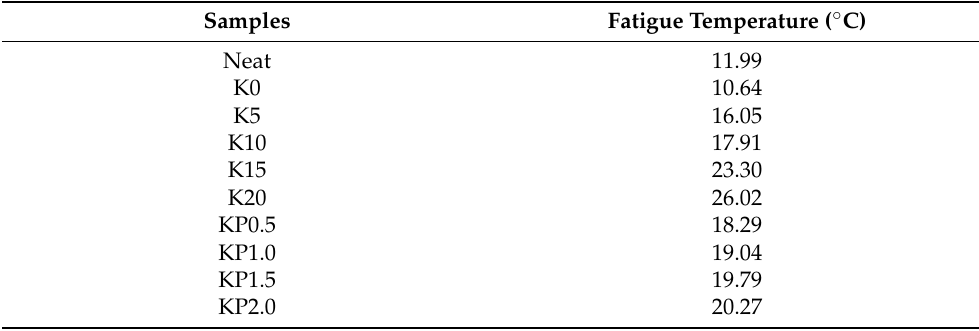
Table 9. Fatigue temperatures of all tested